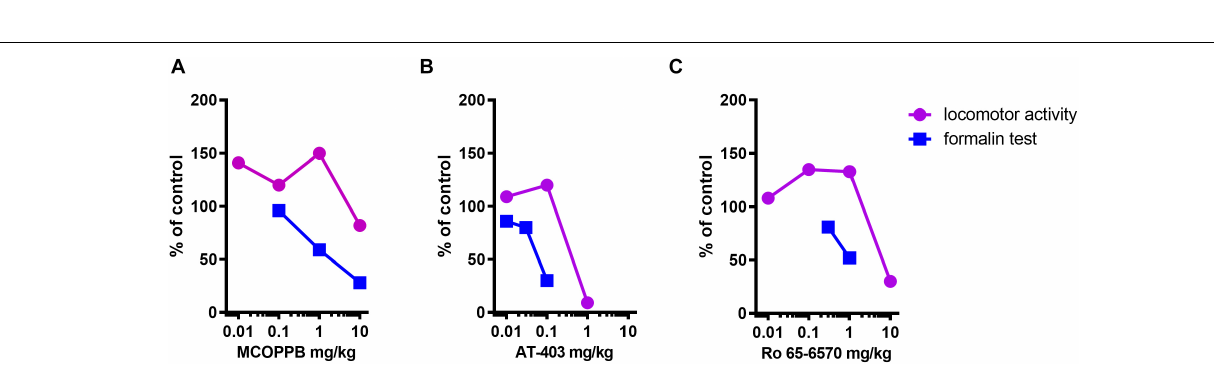
Frontiers in Neuroscience |